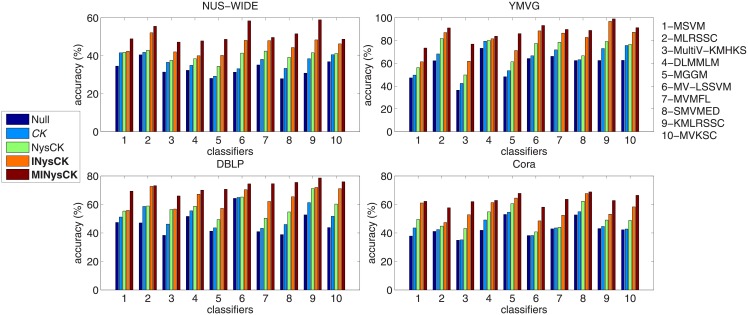
Accuracy with related classifiers and CK-based methods on used multi-view data sets.CK-related method in italic represents baseline one and ones in bold denote the proposed ones. For classifiers, MSVM is used as the baseline one and we just clarify this point in words rather than in font. In other figures and tables, we have similar representations.